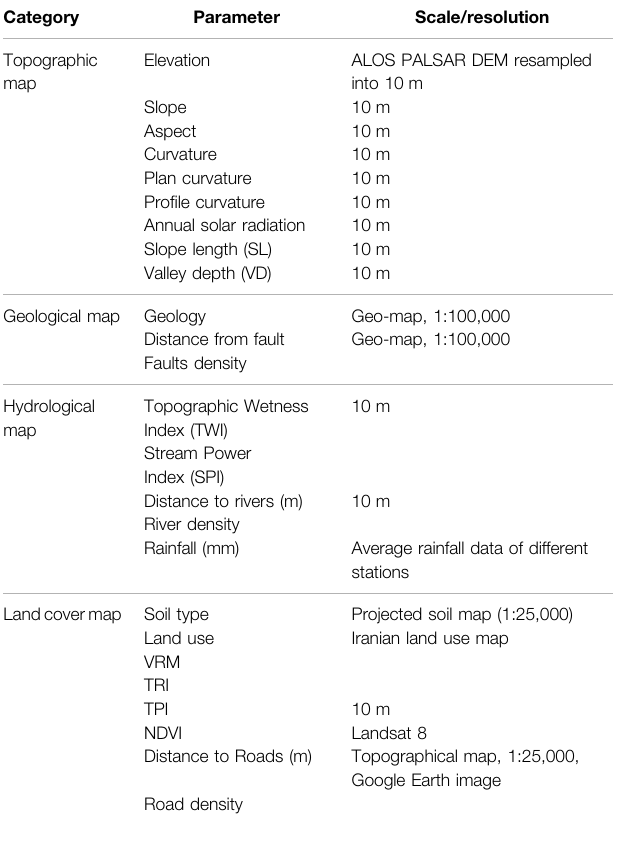
TABLE 1 | Data layers considered as effective factors in the